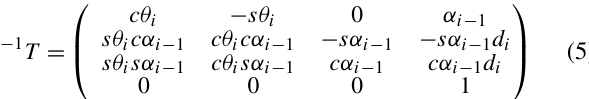
Figure 3. Process of data acquisition.